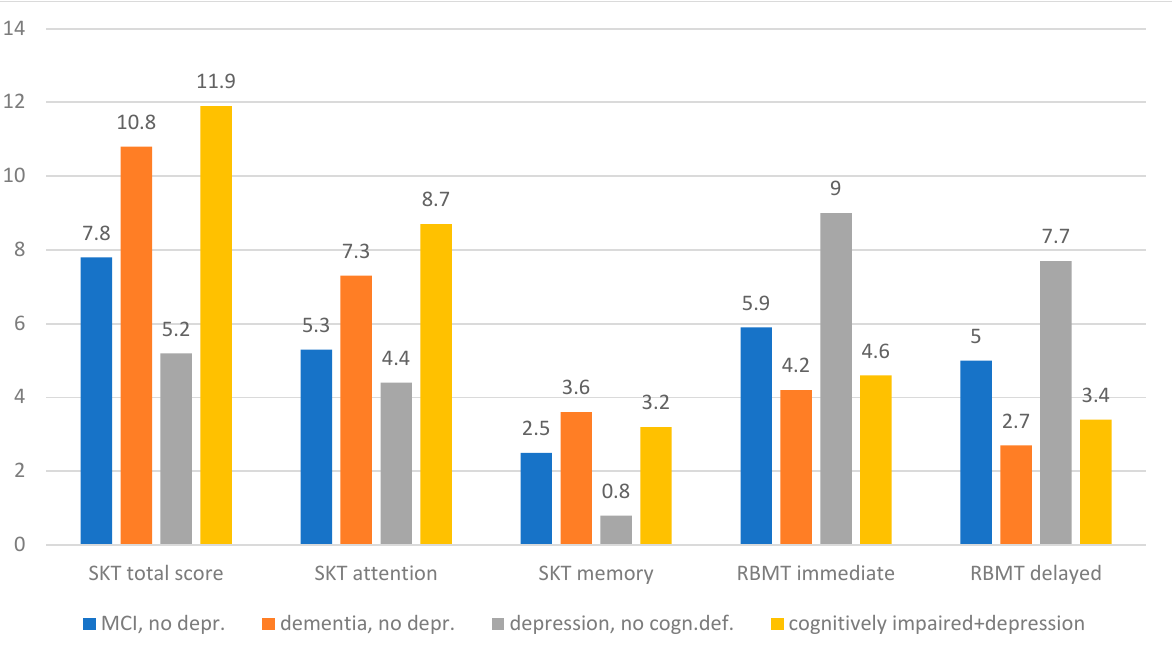
Figure 2. WAIS similarities and NAI maze test: diagnosis groups. Posthoc, a one-way ANOVA with Bonferroni correction (for variance homogeneity) or Games–Howell (for variance inhomogeneity) was performed for each dependent variable (detailed statistical values can be found in the supplement).